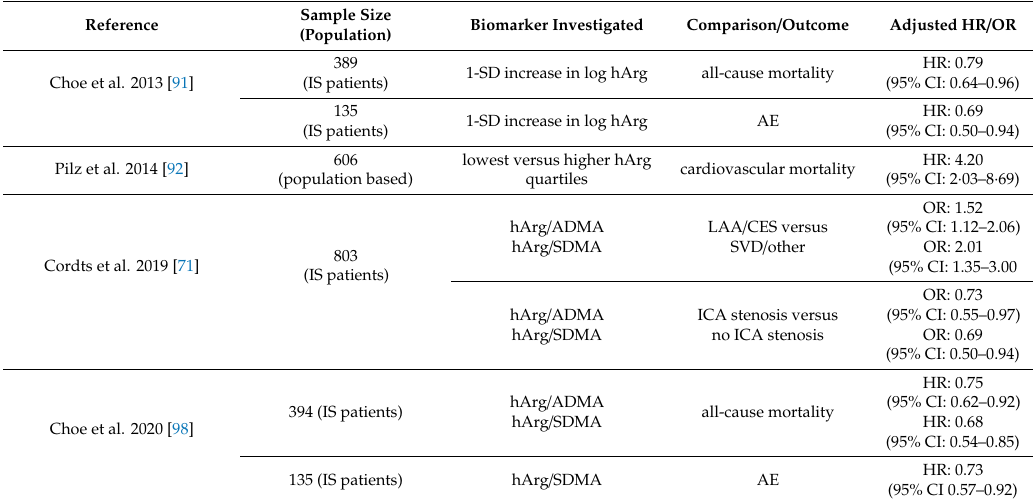
Table 3. Overview on selected clinical studies evaluating hArg in cerebrovascular